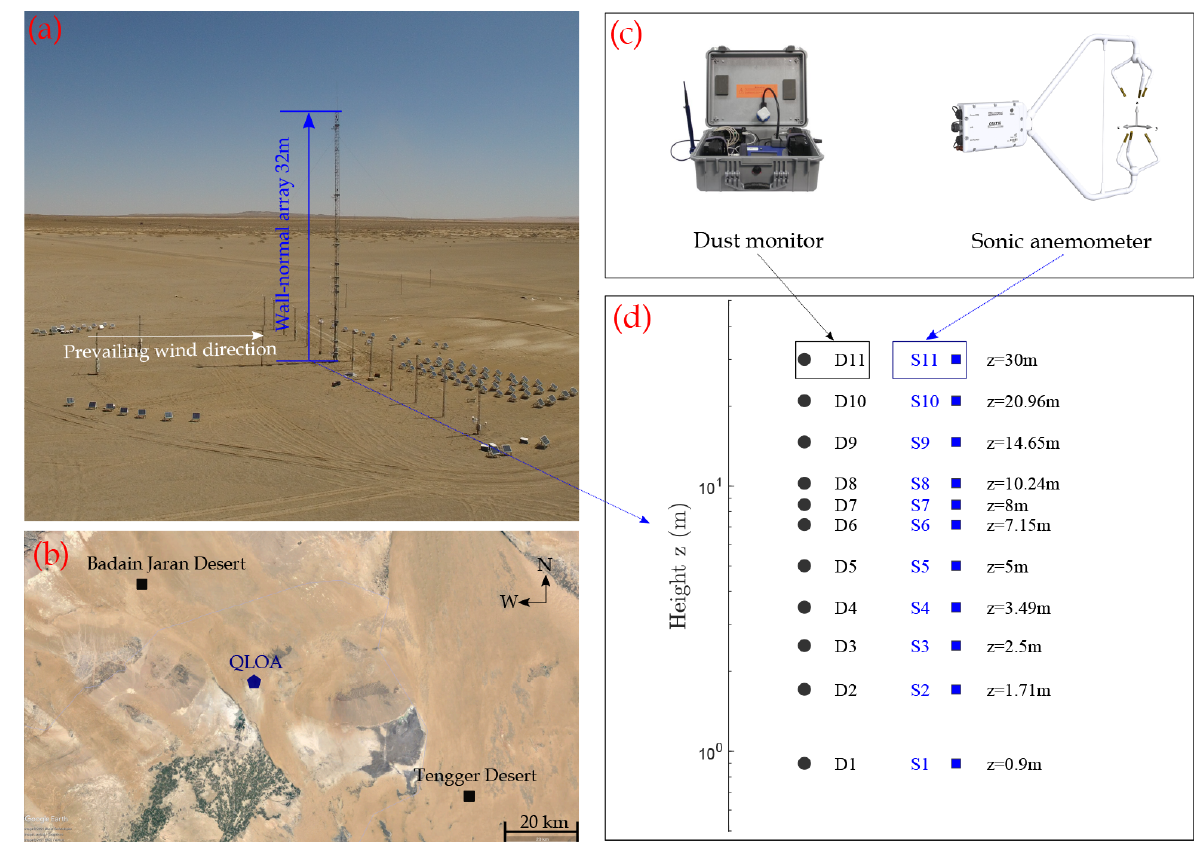
Figure 1. The field observation site and measurement array. (a) Western view of the measurement array installed at the Qingtu Lake Observation Array (QLOA) site. (b) The QLOA site (high-frequency dust events in spring) is located between the Badain Jaran Desert and the Tengger Desert (© Google Earth 2019). (c) Photos of experimental instruments (dust monitor and sonic anemometer). (d) Southeastern view of the array of sonic anemometers (square) and dust monitors (circle; note that the spacing is about 2m between the sonic anemometer and dust monitor at the same height).